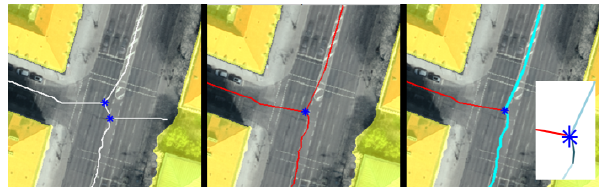
Figure 1: Main steps of chain forming algorithm. Left: vectoriza- tion by means of medial axis; forbidden areas are indicated by the golden color. Middle: The implausible segments are filtered out. We also recommend fusing junctions (denoted by blue crosses) in order to increase the number of neighbors for chain forming (right image). Two segments are fused into a chain (cyan), because their partial dominant direction were similar. The red segment is a side road in this case. Chains and side roads are the main input for the chain-wise generalization, see Sec.